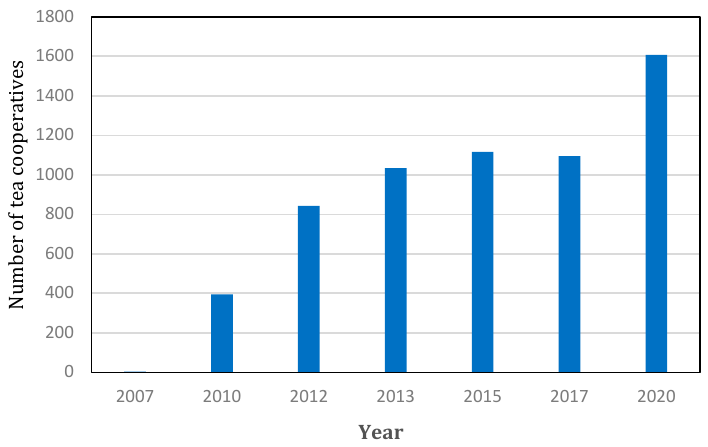
Figure 7. Number change of tea cooperatives in Anxi County.